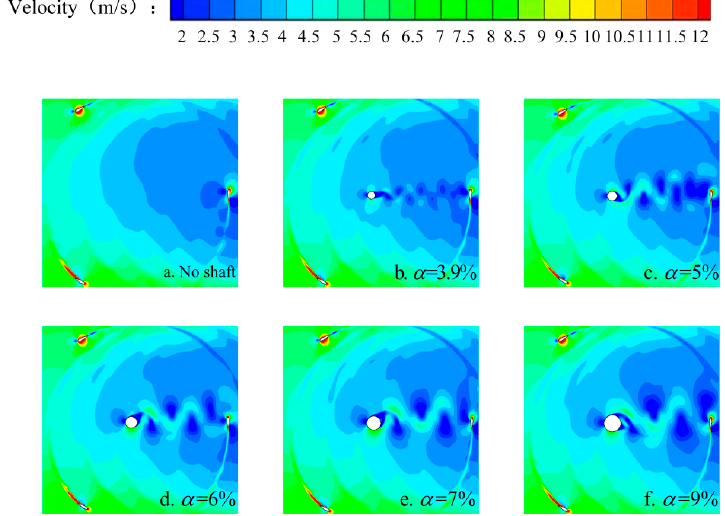
Figure 8. Contours of instantaneous velocity at azimuth angle of 270° with respect to ( a ) no shaft VAWT, ( b ) α = 3.9%, ( c ) α = 5%, ( d ) α = 6%, ( e ) α = 7% and ( f ) α = 9% at TSR = 4.